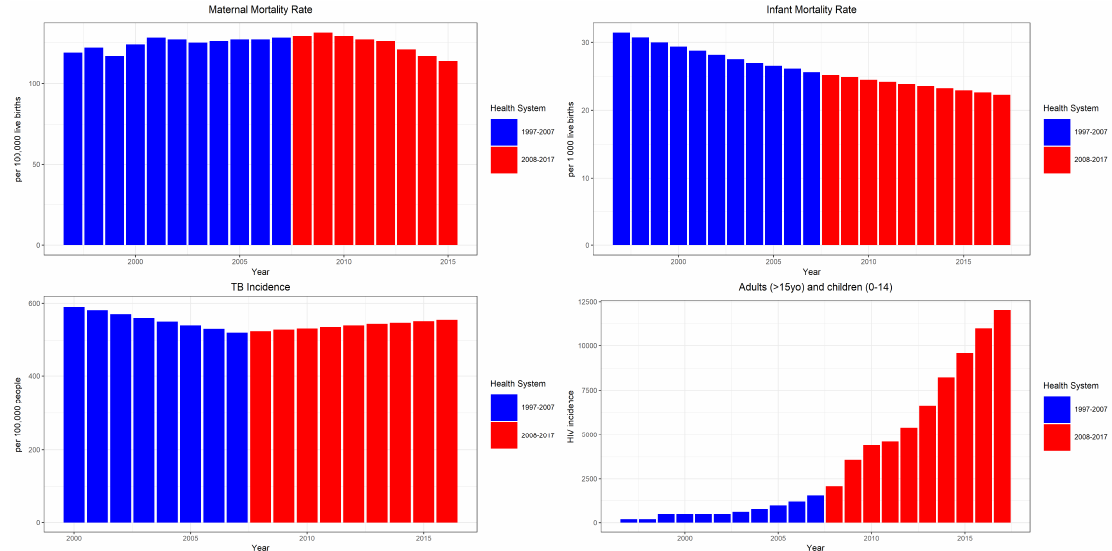
Figure 5. Health determinants in various health